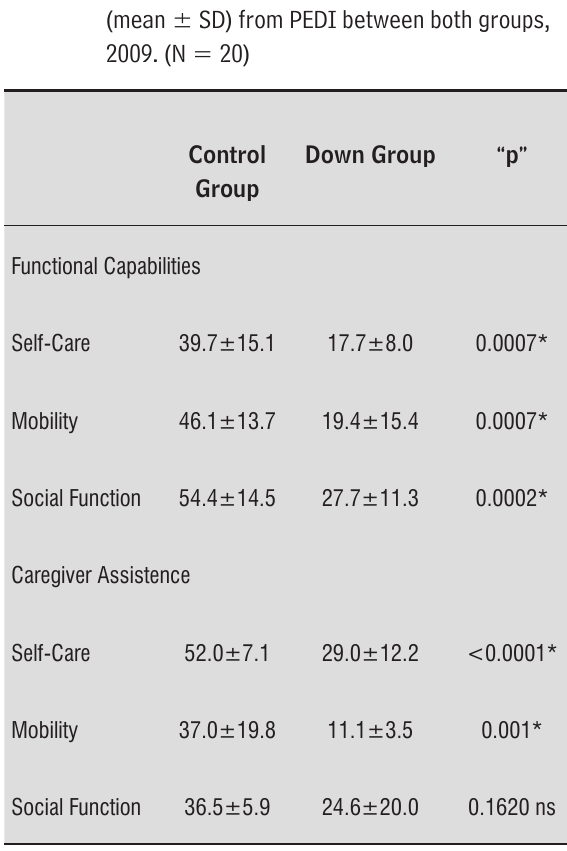
Figure 2 – Comparison of mean scores for normative score in Part II - Caregiver Assistance of PEDI between both groups. (n =